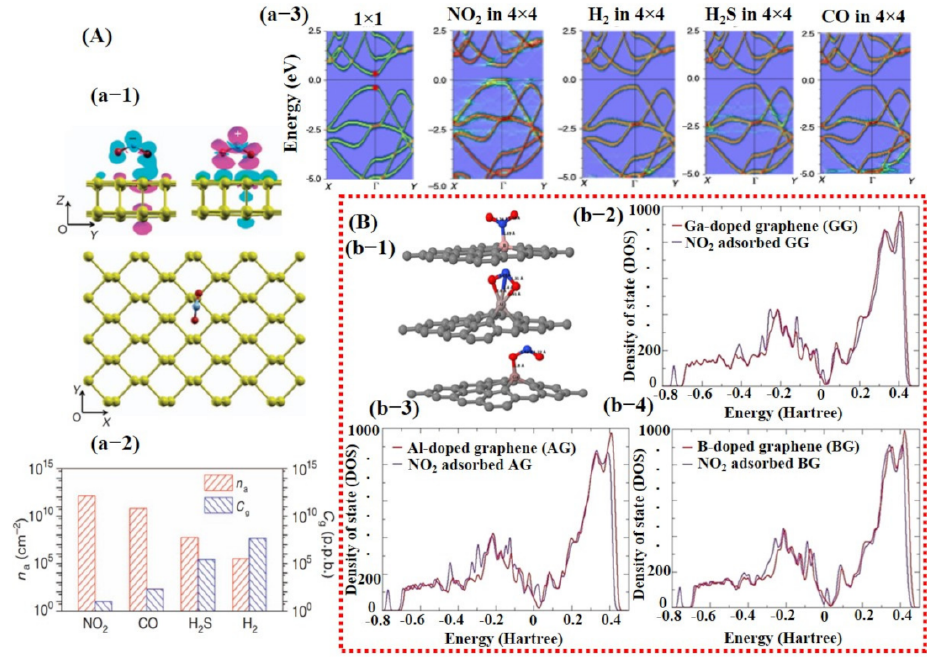
Figure 2. The computational investigation using DFT calculations: ( A ) DFT calculation for phospho- rene: (a-1) shows adsorption of NO 2 molecule on phosphorene surface with oxygen atoms pointing downward and the corresponding generated electron and hole clouds; (a-2) left axis indicates the histogram graph (red bars) with adsorption energies of different gases at fixed 20 ppb concentration; (a-3) displays the change in phosphorene band structure after adsorption of different gases including NO 2 , H 2 , H 2 S, and CO. A clear change on the energy level of conduction band can be observed with the NO 2 adsorption on phosphorene surface, reproduced with permission from [94], copyright 2015 Nature. ( B ) DFT calculations of boron (B)-, aluminum (Al)-, and gallium-(Ga) doped graphene for NO 2 detection: (b-1) illustrates a schematic for the NO 2 molecule adsorption on all three kinds of graphene surfaces—clear and strong adsorption of NO 2 molecule on Al-doped graphene can be seen (middle image); (b-(2–4)) show DOS for all kinds of graphene when exposed to NO 2 —Al-doped graphene displayed maximum change at Fermi energy level suggesting its higher sensing ability toward NO 2 molecule (b-3). Reproduced with permission from [95], copyright 2016